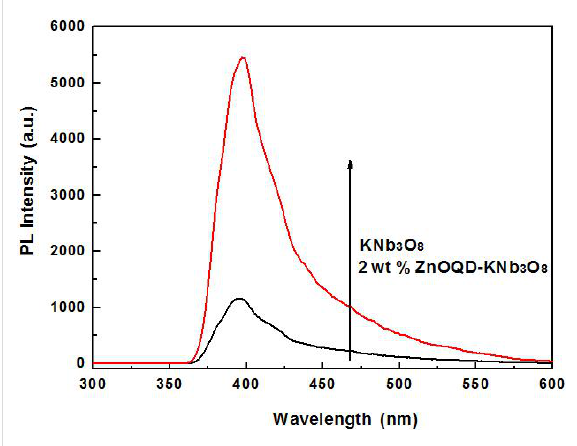
Figure 10: Photoluminescence (PL) spectra of the 2 wt % ZnO quan- tum dot/KNb 3 O 8 nanosheet composite photocatalyst (black) com- pared to KNb 3 O 8 nanosheets (red).